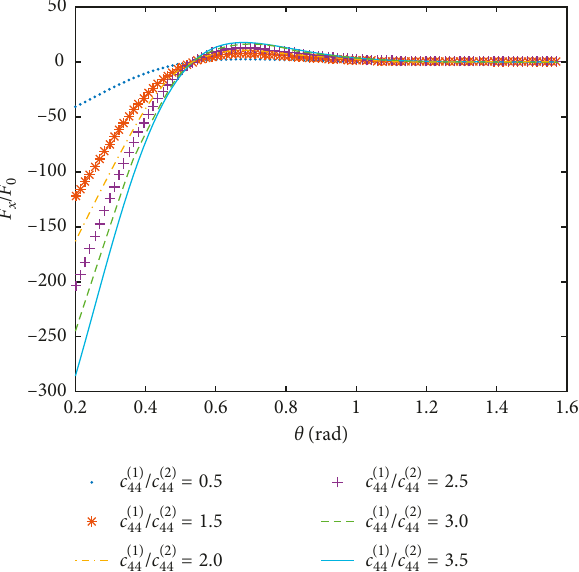
Figure 8: Relationship between image force F different values of the parameter c ( 1 )